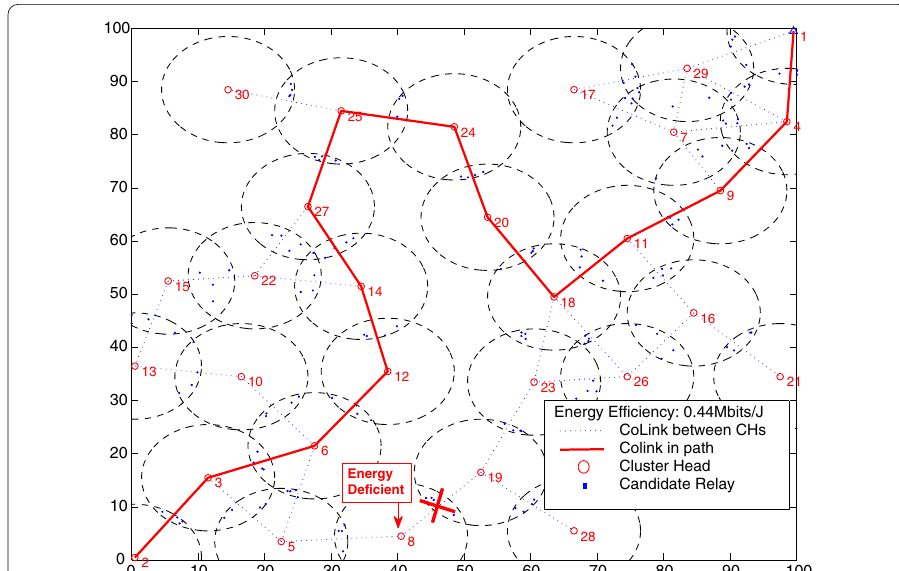
Fig. 8 An example for Path solution under CH‑IT mode